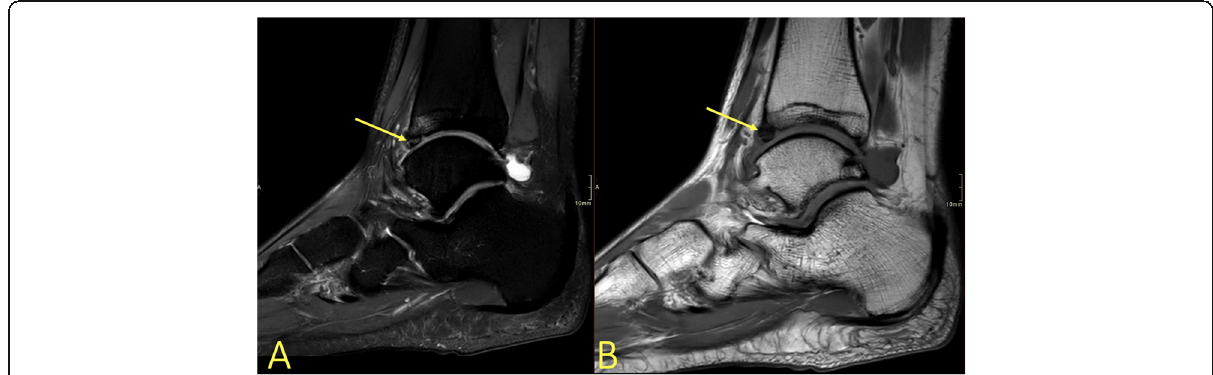
showing anterior